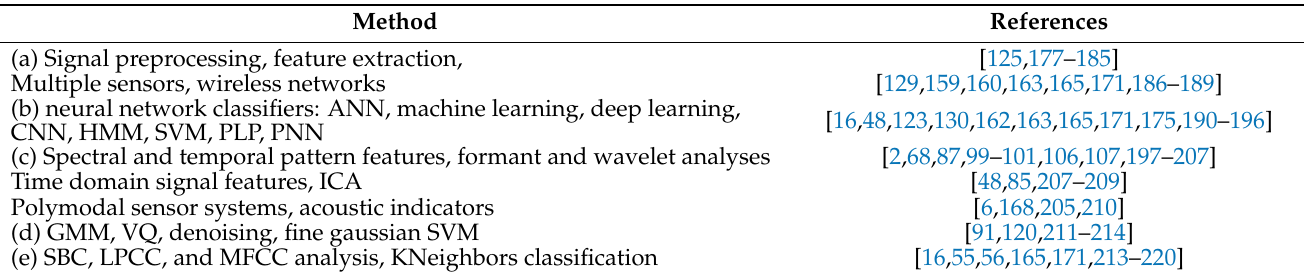
Table 3. Examples of automated signal recognition and classification activities subdivided according to approximate order of first usage with insects (Methods abbreviations are defined in the